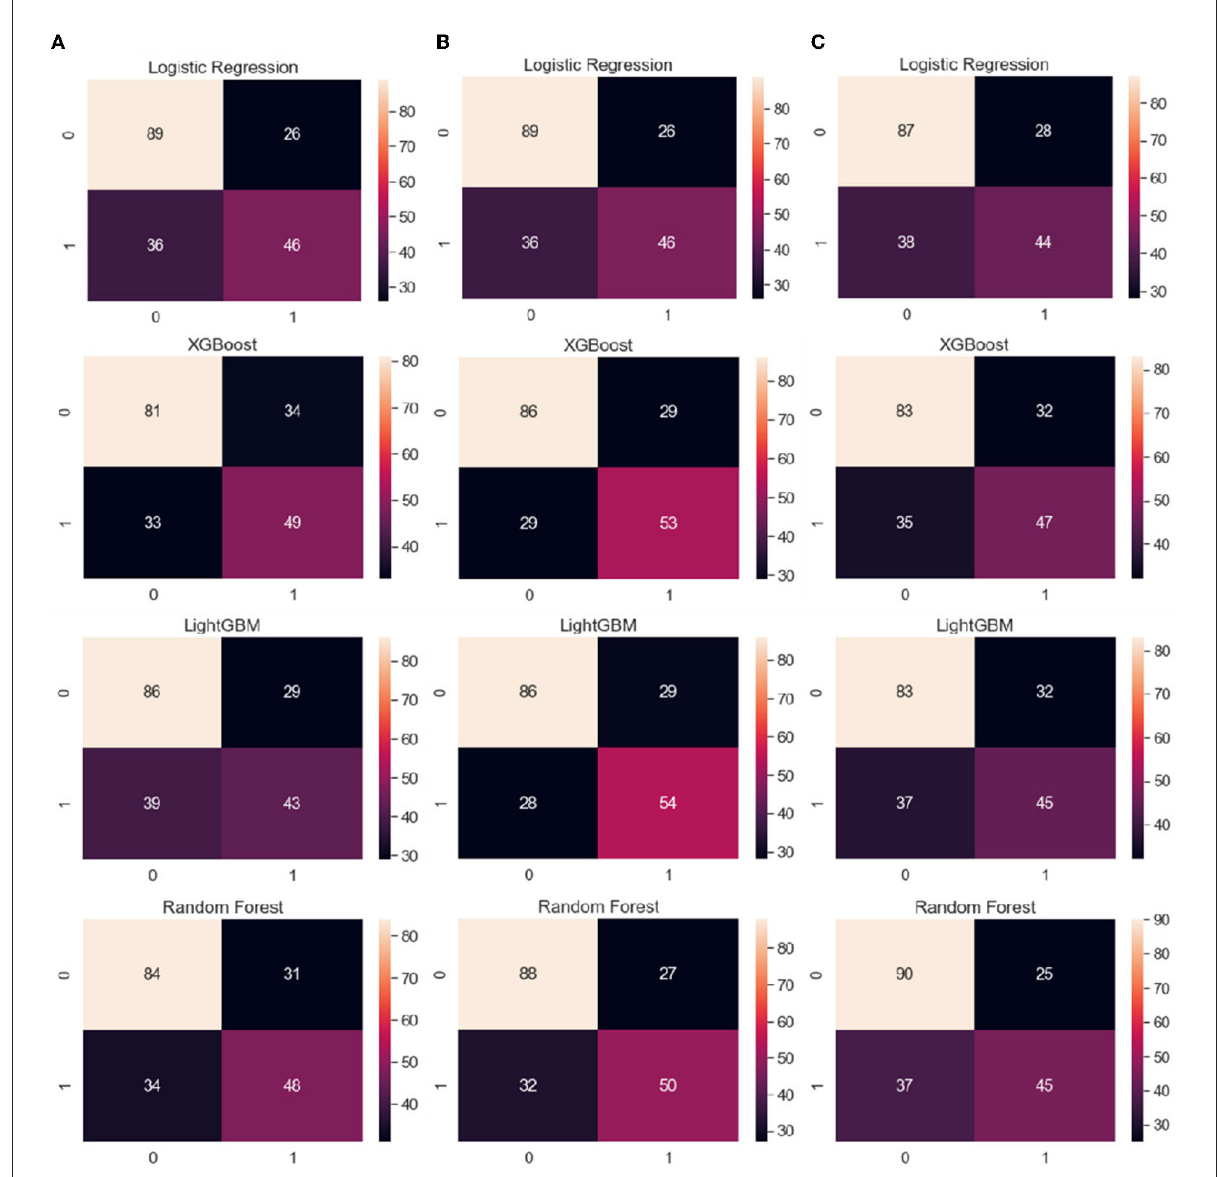
FIGURE3 From the left, the average confusion matrix for each ML model when using the features of (A) clinical data, (B) clinical data with CVRS, and (C) clinical data with cortical thickness, respectively. The x-axis and y-axis represent the predicted values and the actual ground truth values,